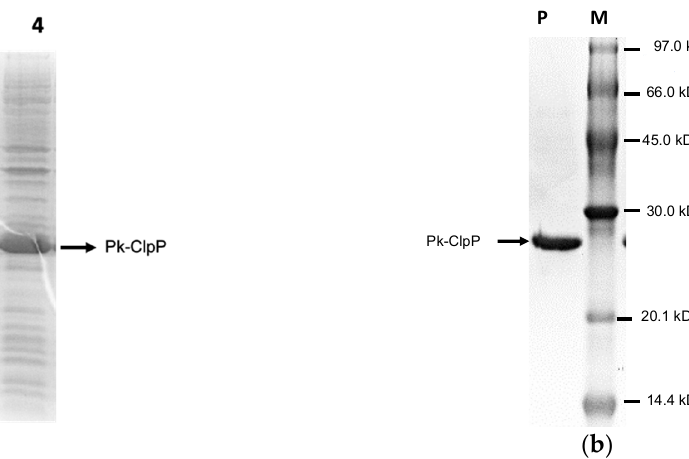
Figure 3. ( a ) Expression and solubility check of the ClpP from Plasmodium knowlesi (Pk-ClpP) by 15% SDS-PAGE. The M lane refers to the protein markers (kDa); Lanes 1 and 2 correspond to fractions before and after IPTG inductions, respectively; Lane 3 and 4 refer to pellet and soluble fractions obtained after cell lysis (sonication), respectively. ( b ) Purified Pk-ClpP under 15% SDS-PAGE. The P lane indicates the purified protein. The band corresponding to the Pk-ClpP protein is indicated by the arrow. Table 1. Purification of Pk-ClpP with Ni 2+ -NTA affinity chromatography.